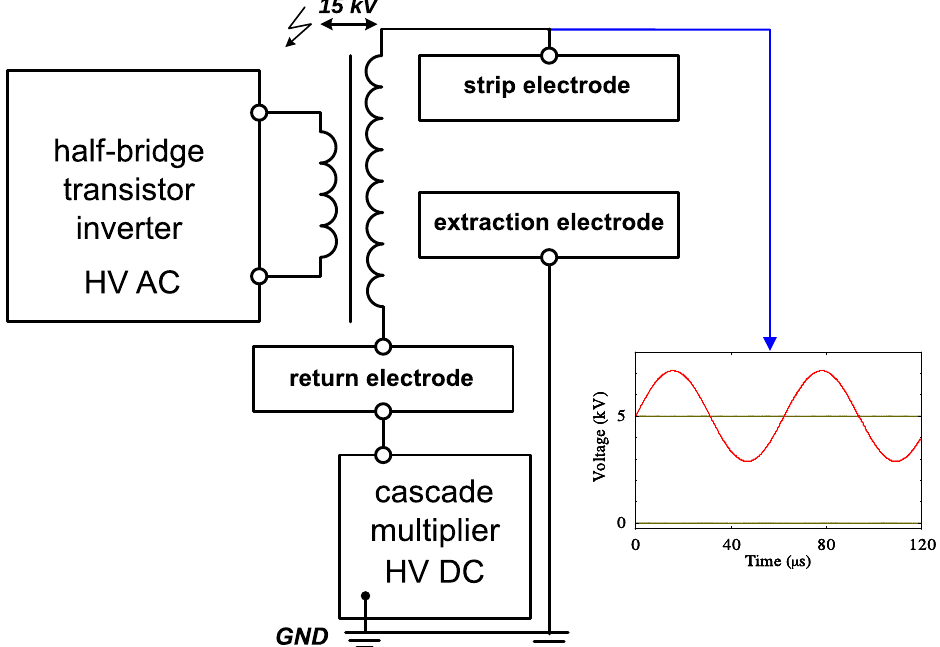
Figure 6. Connecting scheme of the power sources to the